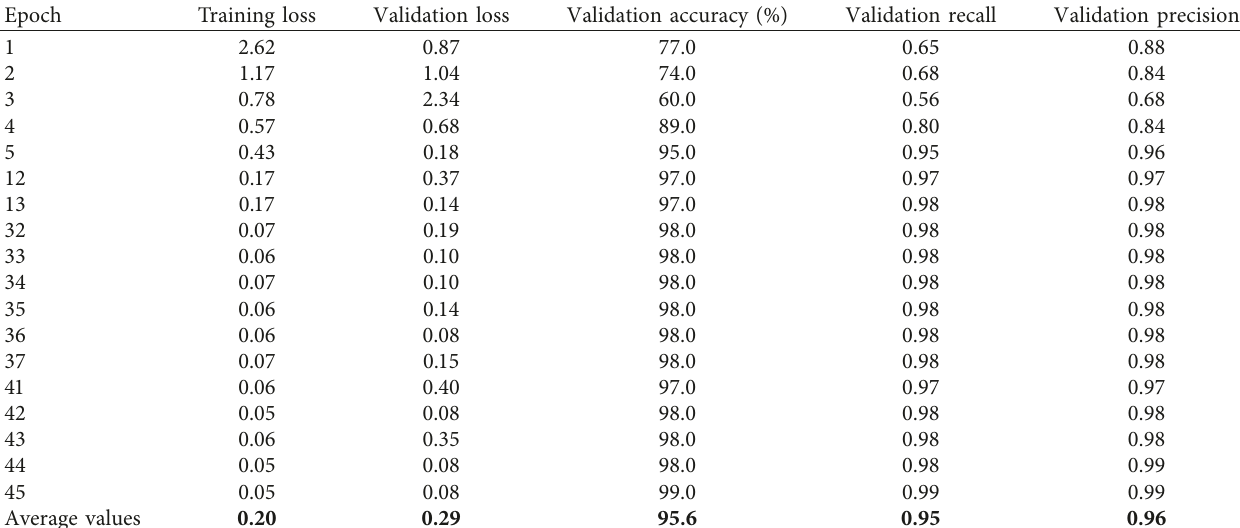
Table 3: Results obtained with the proposed CNN model.